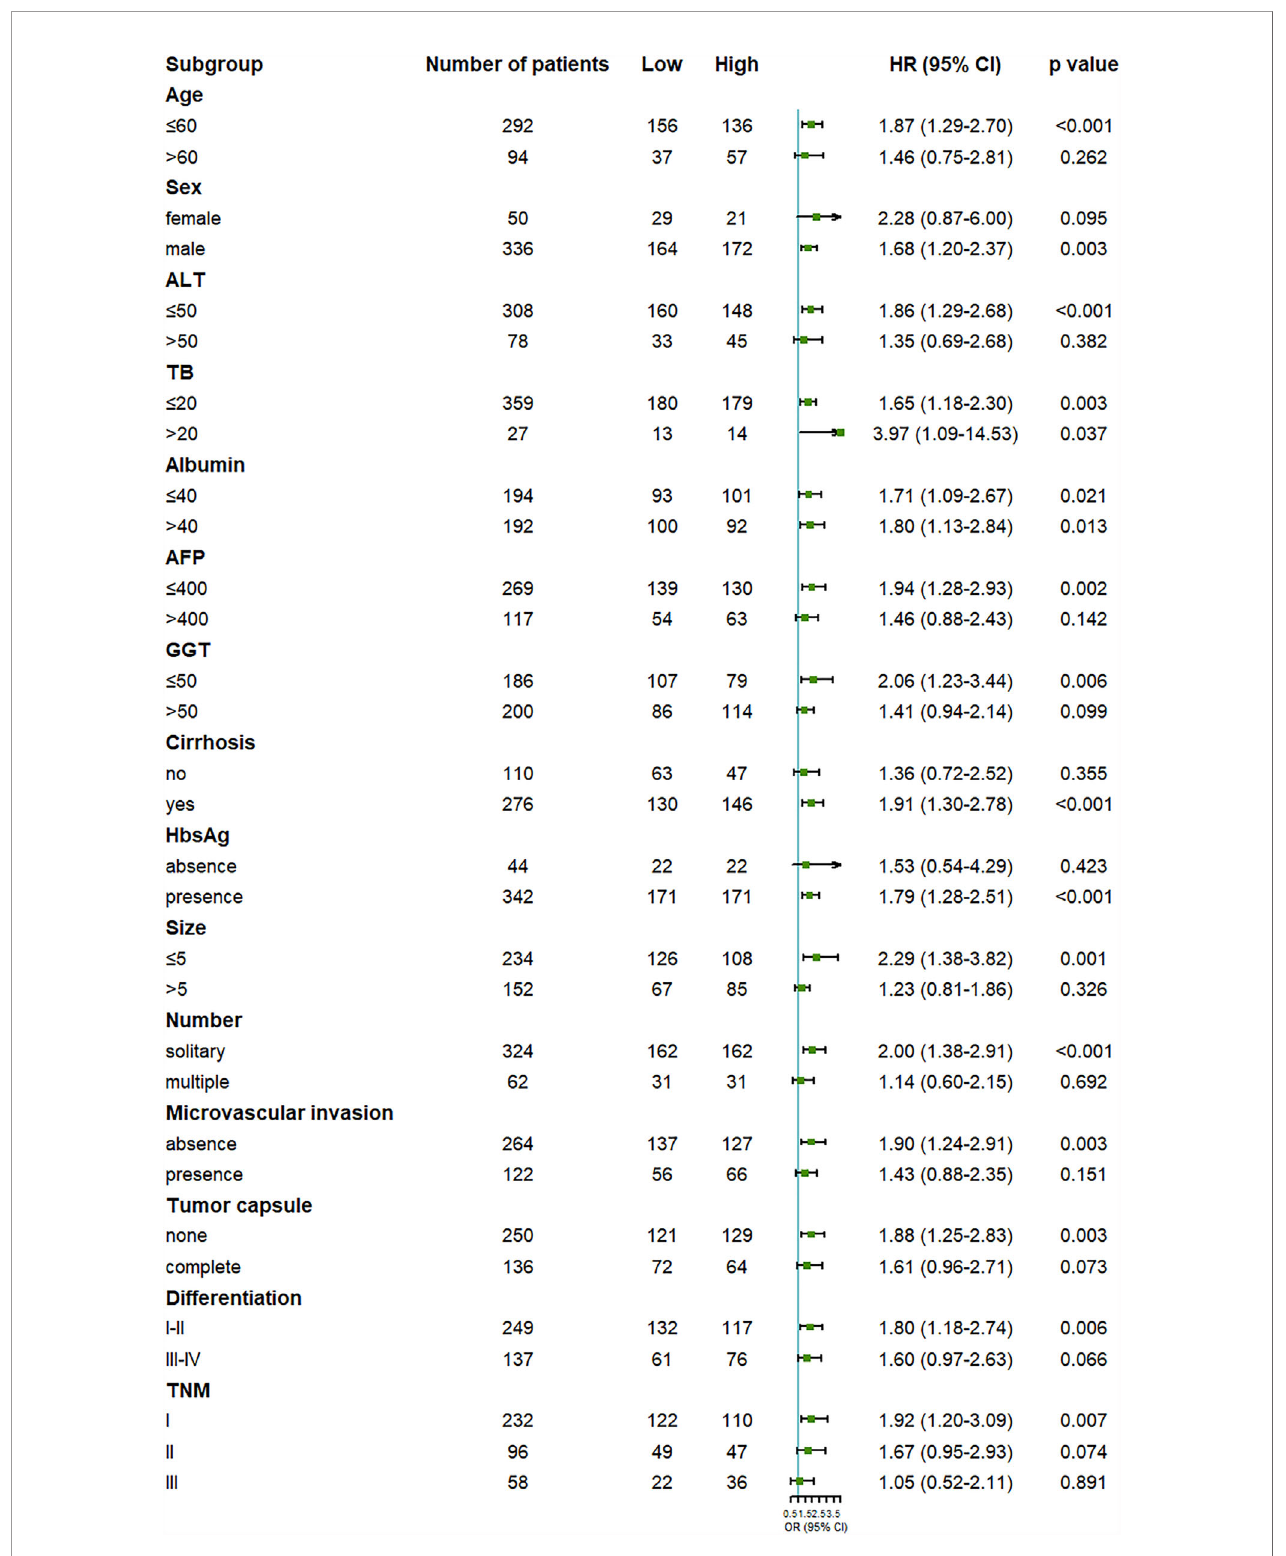
FIGURE 2 | Forest plot showing the effect of serum OPG levels on overall survival in HCC patients strati fi ed by different clinicopathological factors before matching. HR>1 and p<0.05 suggested that higher OPG levels in serum were associated with poorer survival outcome.